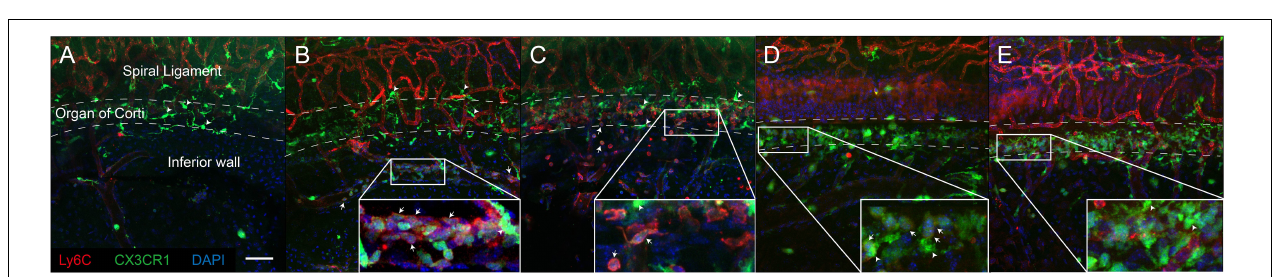
FIGURE 4 | Inflammatory monocytes mainly infiltrated the lower portion of the lateral wall of the cochlea. Immunofluorescence studies of the lateral wall of the cochlea revealed that inflammatory monocytes (positive for Ly6C, weak CX3CR1) aggregated and infiltrated into the lower portion of the lateral wall after acoustic stimulation. (A) Control. (B) 1 dpn. (C) 2 dpn. These cells transform to macrophages expressing CX3CR1 with losing Ly6C after 2 dpn. (D) 3 dpn. (E) 5 dpn. Arrows indicate representative inflammatory monocytes (expressing both Ly6C and CX3CR1). Arrowheads indicate representative resident cochlea